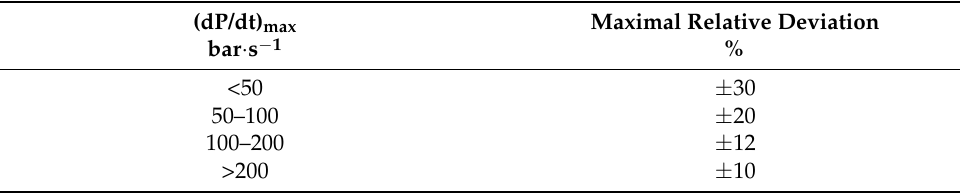
Table 2. Permissible deviations of (dP/dt) max measurement for standard equipment of 1 m 3 (value (dP/dt) max correspond to value K st ). (dP/dt) max bar · s −